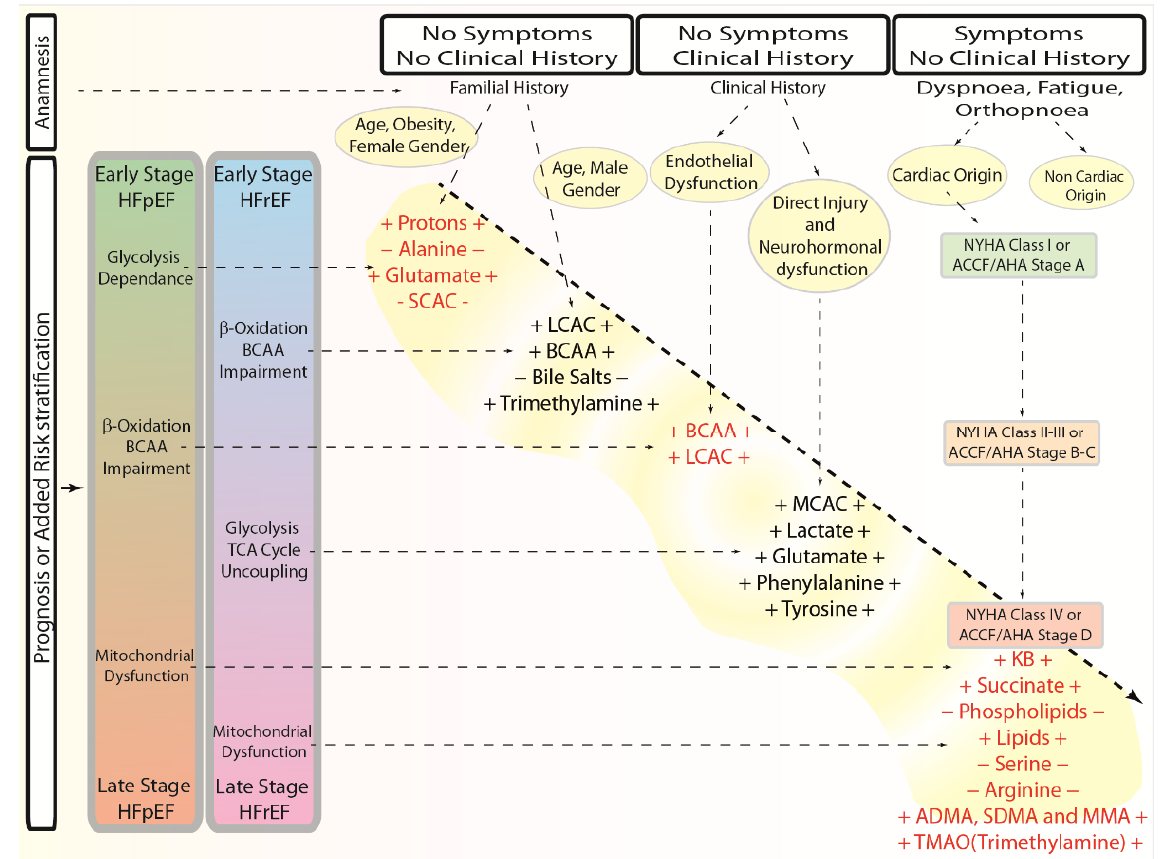
Figure 7. Flowchart of the proposed approach to consider metabolic markers’ expression in anamnesis, prognosis, or risk stratification of HFpEF and HFrEF.